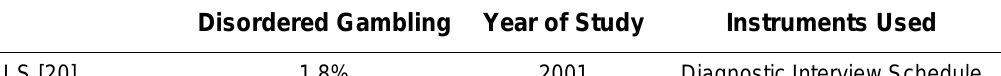
Comparison of 12-Month Prevalence of Disordered Gambling in the U.S., New Zealand, and Hong